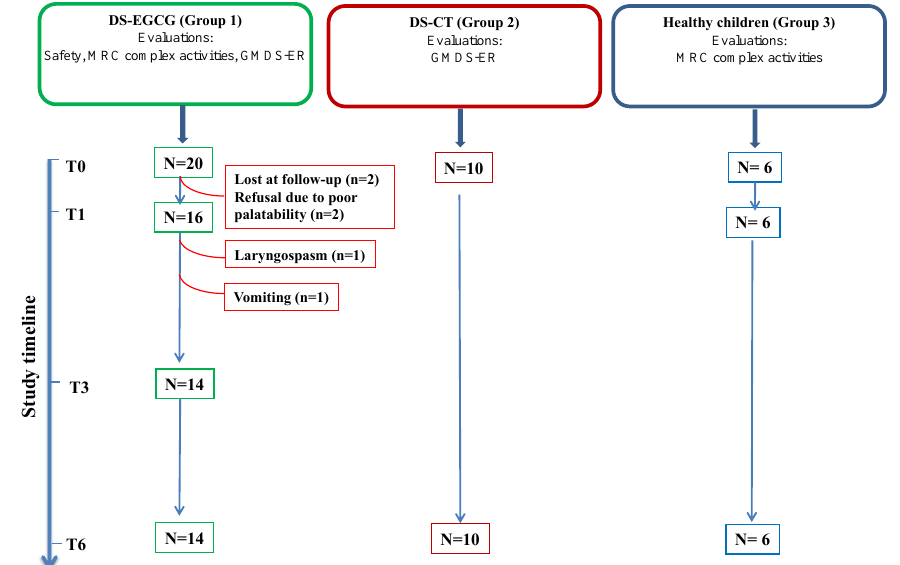
Scheme 1. Study diagram. DS-EGCG: DS children treated with EGCG (Group 1); DS-CT: DS control group (Group 2); Healthy children (Group 3). N, patient number; safety evaluation was performed at baseline (T0), after 1 month (T1), after 3 months (T3) and after 6 months (T6) of EGCG supplementation. Griffiths Mental Developmental Scales—Extended Revised (GMDS-ER) evaluations were performed at T0 and at T6. Mitochondrial respiratory chain (MRC) complex activ- ities were evaluated at T0, T1 and T6. Red lines indicate patient’s dropout.